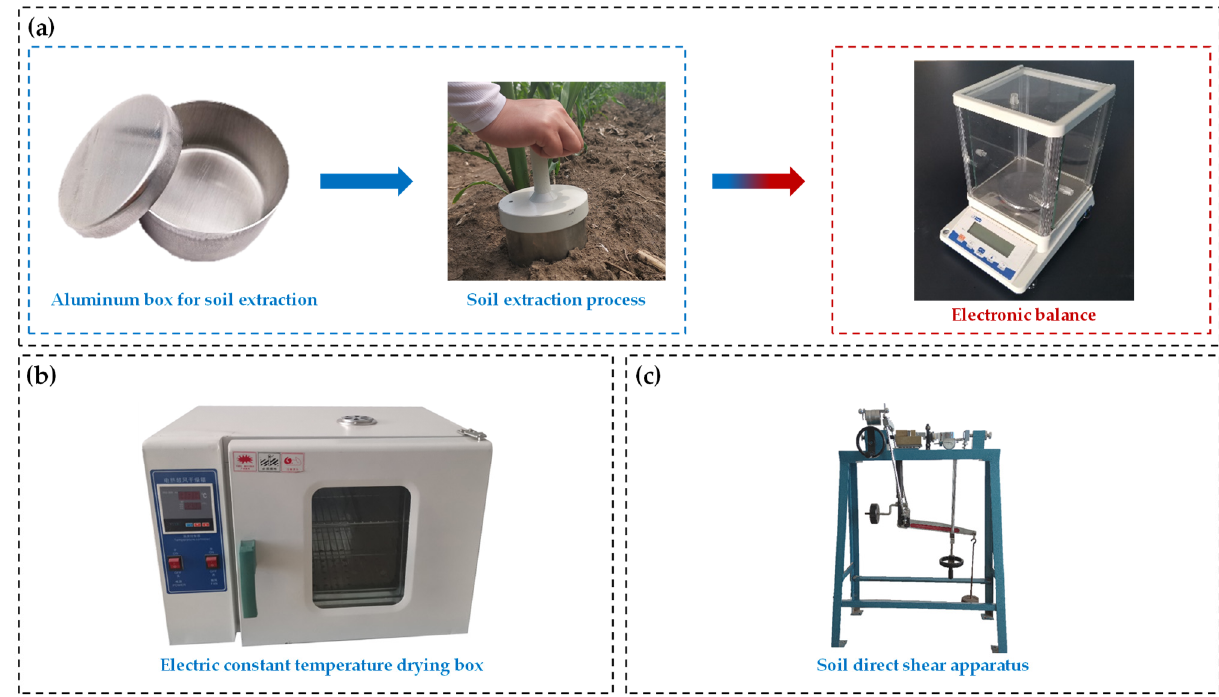
Figure 1. Measurement process and equipment for measuring black soil physical parameters. ( a ) Measurement process and equipment for measuring black soil bulk density parameters. ( b ) Measurement process and equipment for measuring black soil moisture content. ( c ) Measurement process and equipment for measuring black soil shear modulus and Poisson’s ratio parameters.